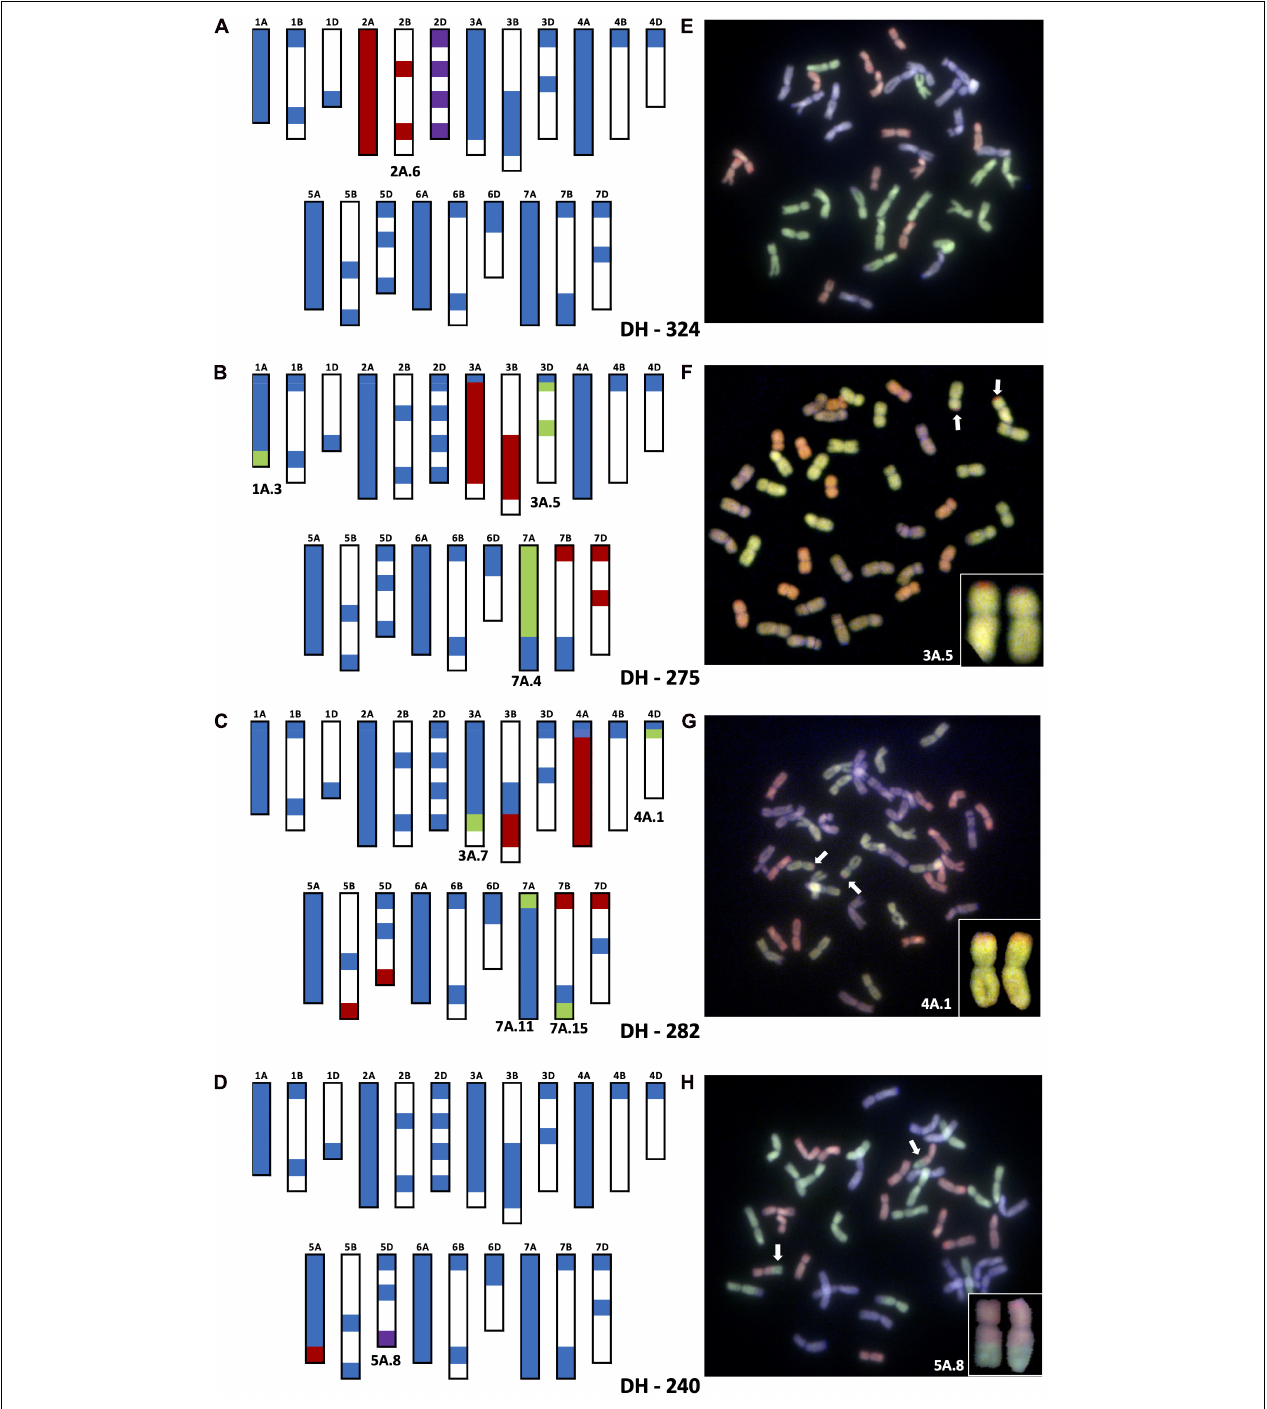
FIGURE 2 | Molecular characterization of wheat– T. urartu DH lines showing genotyping analysis with chromosome–specific KASP assays (A–D) and Genomic in situ hybridization (GISH) images of root metaphase spreads (E–H) . Panels (A,E) showing presence of whole chromosome 2Au (2A.6) substituting for Chr 2D in DH-324. Panels (B,F) showing the introgression of segment 3A.5 into Chr 3D of wheat in DH-275. Panels (C,G) showing the introgressions of segment 4A.1 into Chr 4D of wheat in DH-282. Panels (D,H) showing the introgression of segment 5A.8 into Chr 5D of wheat. In the genotyping data, all heterozygous calls are shown in red, homozygous wild relative calls in green, homozygous wheat calls in blue and null calls are shown in purple. White spaces indicate regions where KASP markers are not present. For the GISH, green represents the A-genome of wheat or A u -genome of T. urartu , greyish purple, the B-genome and red, the D-genome of wheat. Identifiable introgressions are indicated by white